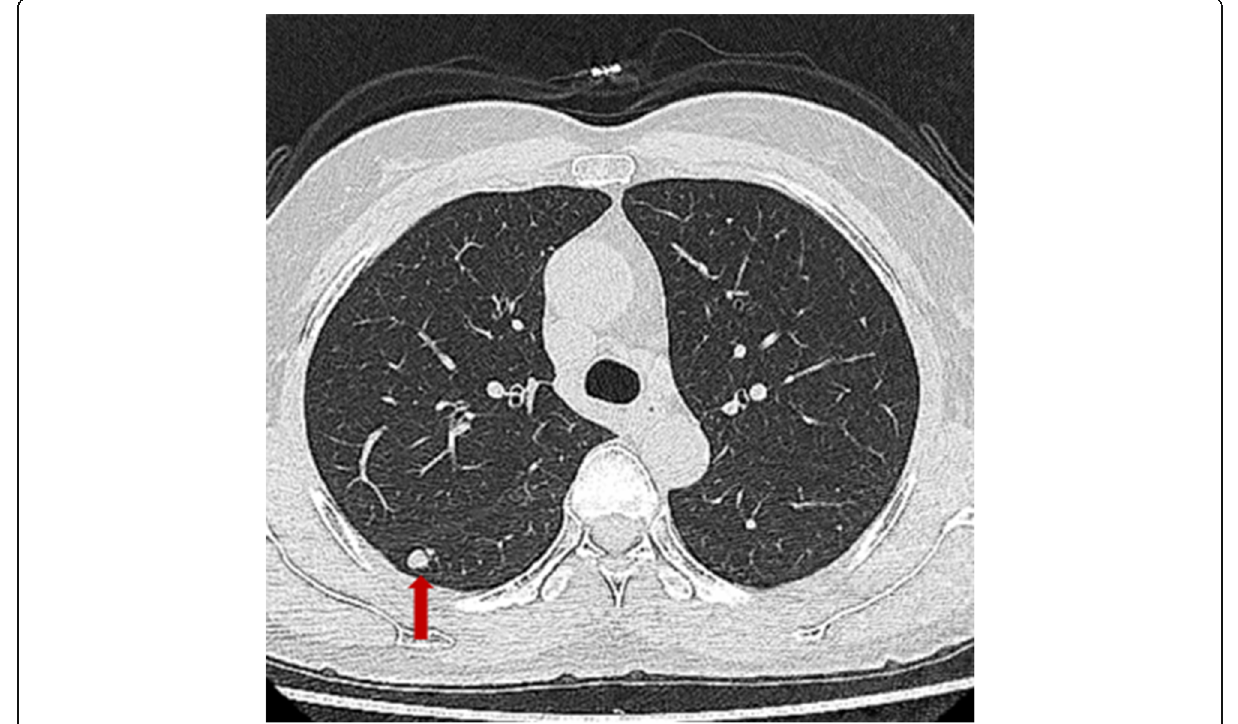
Fig. 1 Chest computed tomographic image reveals a well-demarcated, round, solid nodule in the right lung (red